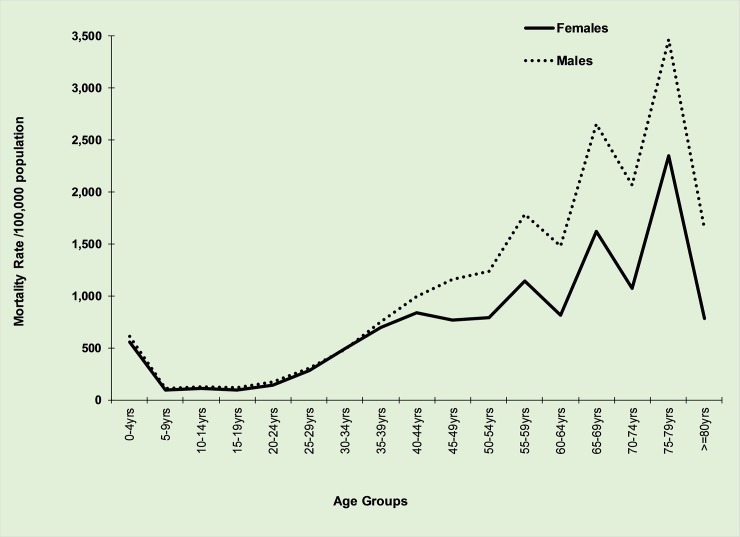
Age-sex mortality rate per 100,000 population, 2006–2015.